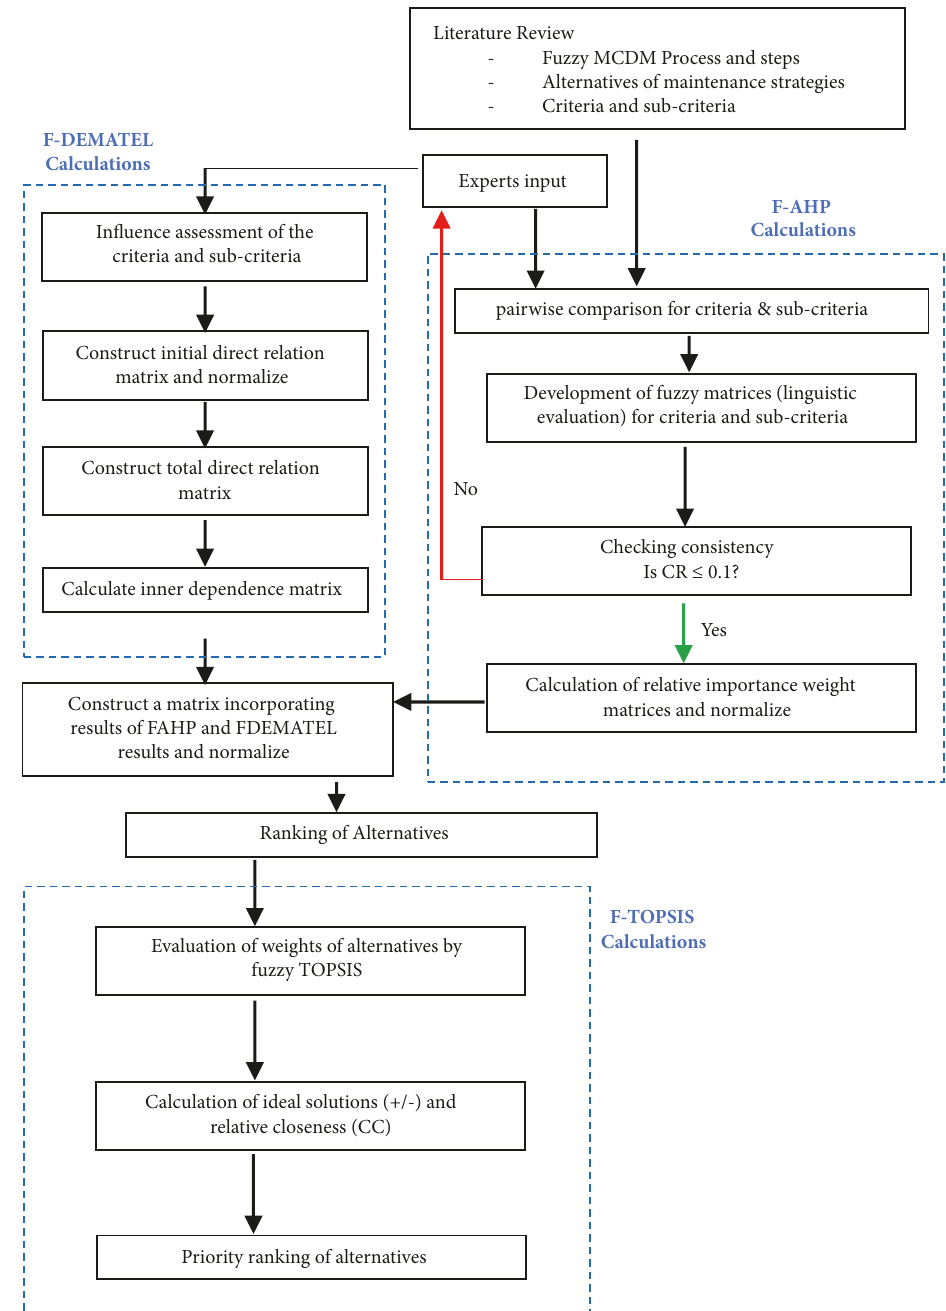
Figure 4: Process chart of the model design of the